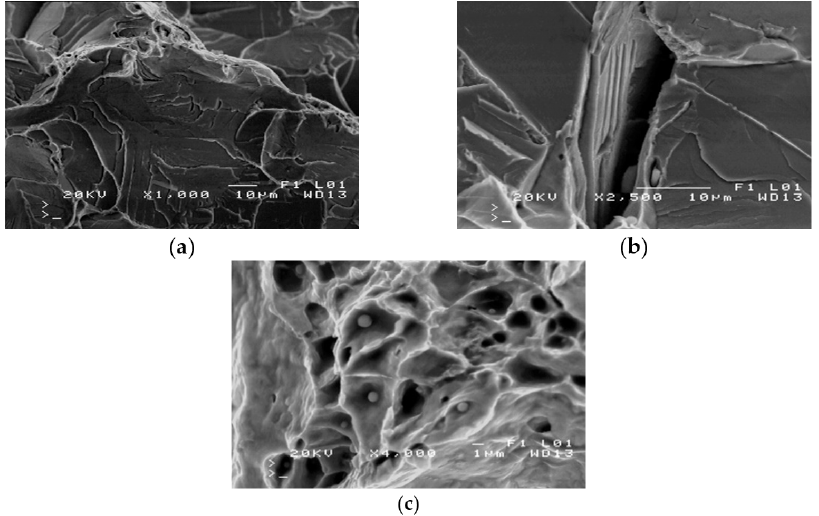
Figure 47. Scanning electron microscope (SEM) views (handy-size bulk carrier 30185 DWT): ( a ) brittle fracture produced after impact testing at − 20 ◦ C; ( b ) fracture-based crack that runs through a pearlite grain; and ( c ) a fragment of crater-like ductile fracture (spherical precipitates of Fe and Si oxides are visible at the bottom of